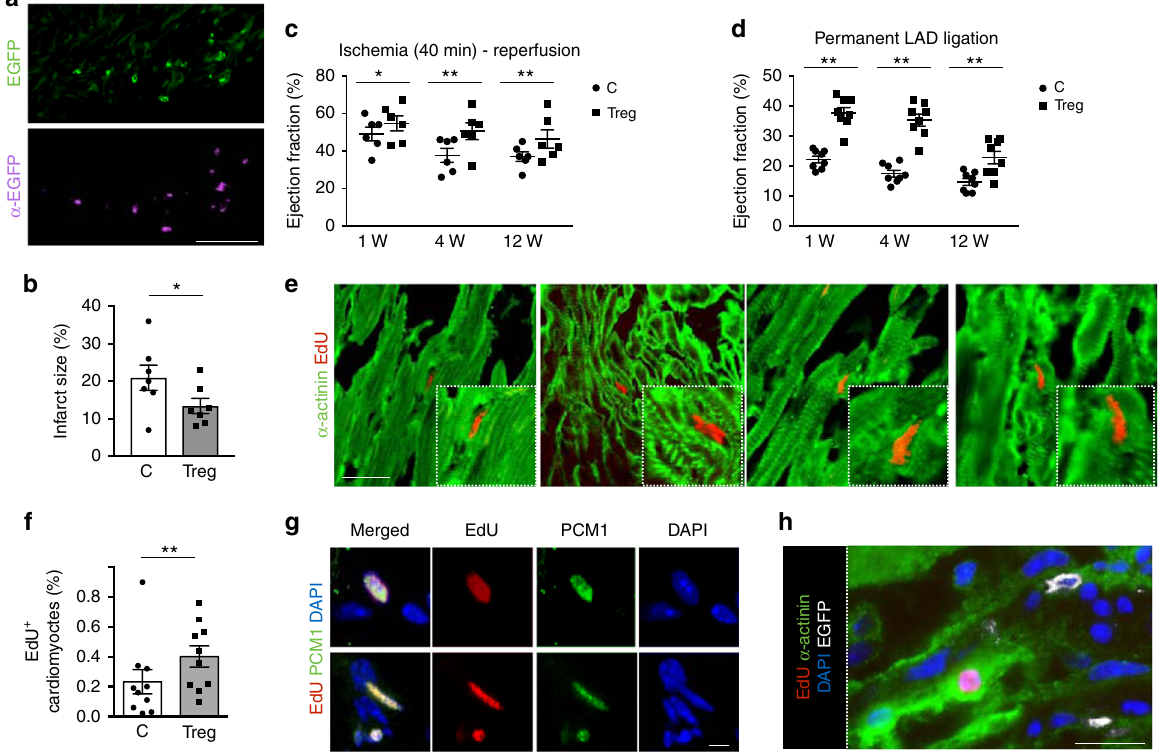
Fig. 5 Treg administration improves the outcome of myocardial infarction. a Tregs sorted by DEREG mice were injected into the border region of the myocardial infarction and visualized as EGFP + cells in heart section at day 3 after surgery, detecting either the endogenous green fl uorescence (upper panel) or using anti-EGFP antibodies (purple, lower panel). Scale bar, 25 μ m. b Quanti fi cation of infarct size expressed as percentage of the left ventricular area in control (C, circles) and Treg-injected (Treg, squares) mice at 3 months after myocardial infarction. c US imaging analysis of the left ventricular ejection fraction of control (C) and Treg-injected (Treg) mice at 1, 4, and 12 weeks (W) after 40 min (min) of coronary artery ligation followed by vessel reperfusion. d US imaging analysis of the left ventricular ejection fraction of control (C) and Treg-injected (Treg) mice at 1, 4, and 12 weeks (W) after permanent ligation of the left descendent anterior (LAD) coronary artery. e Sections of the heart of Treg-injected mice, showing EdU incorporation (stained red) in the nuclei of CMs (stained green by anti- α -actinin antibodies). Scale bar, 100 μ m. f Quanti fi cation of the EdU incorporation (% of total CM nuclei) in CMs in control (C) and Treg-injected (Treg) hearts at 15 days after permanent coronary artery ligation. g Sections of the heart of Treg-injected mice, showing EdU incorporation (stained red) in the nuclei of CMs (stained green by anti-PCM1 antibodies). Nuclei are stained in blue with DAPI. Scale bar, 10 μ m. h Section of the heart showing injected Tregs (labeled in white by anti-EGFP antibodies) in proximity of one EdU + CM (EdU is labeled in red and CMs in green by anti- α -actinin antibodies). Nuclei are stained in blue with DAPI. Scale bar, 50 μ m. All values are mean ± s.e.m. each dot indicates a biological replicate. Pairwise comparison was performed with the Student ’ s t -test ( b , f ). Two-way ANOVA for repeated measurements was used in ( c , d ). * P <